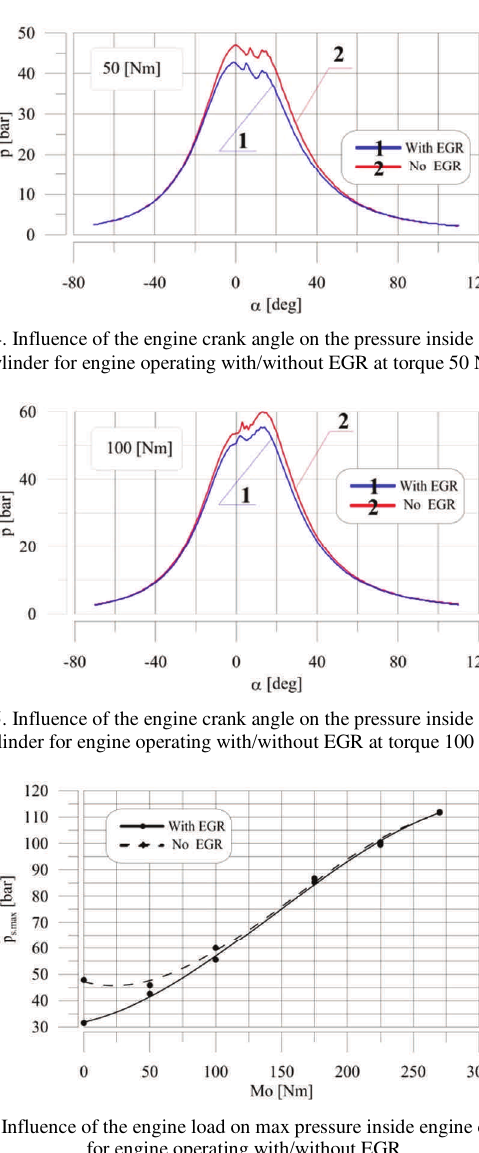
Fig. 3. Influence of the engine crank angle on the pressure inside engine cylinder for engine operating with/without EGR at torque 0 Nm